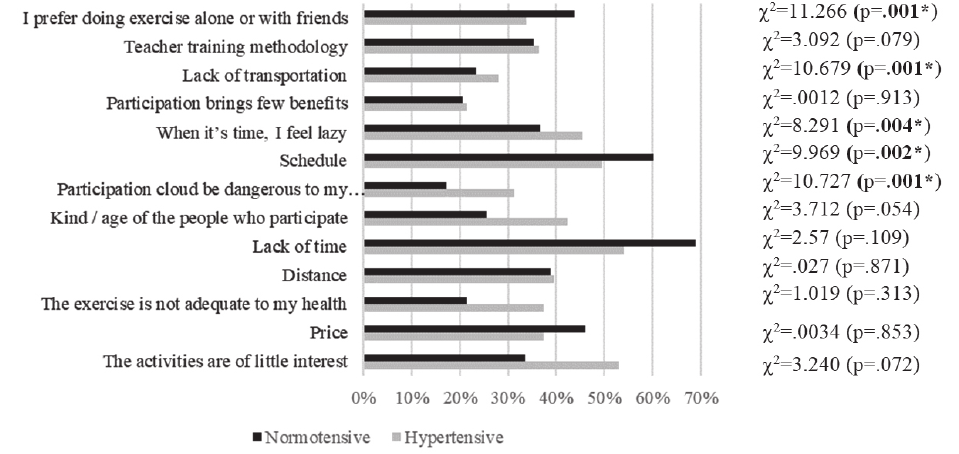
Figure 1. Causes of non-participation physical activities programmes